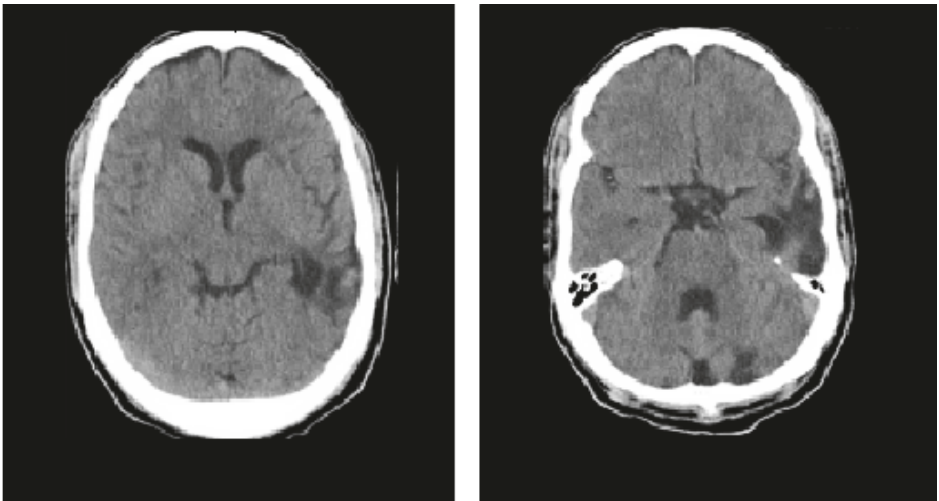
Figure 1: (Day 1) noncontrast CT head showing encephalomalacia on the left hemisphere without